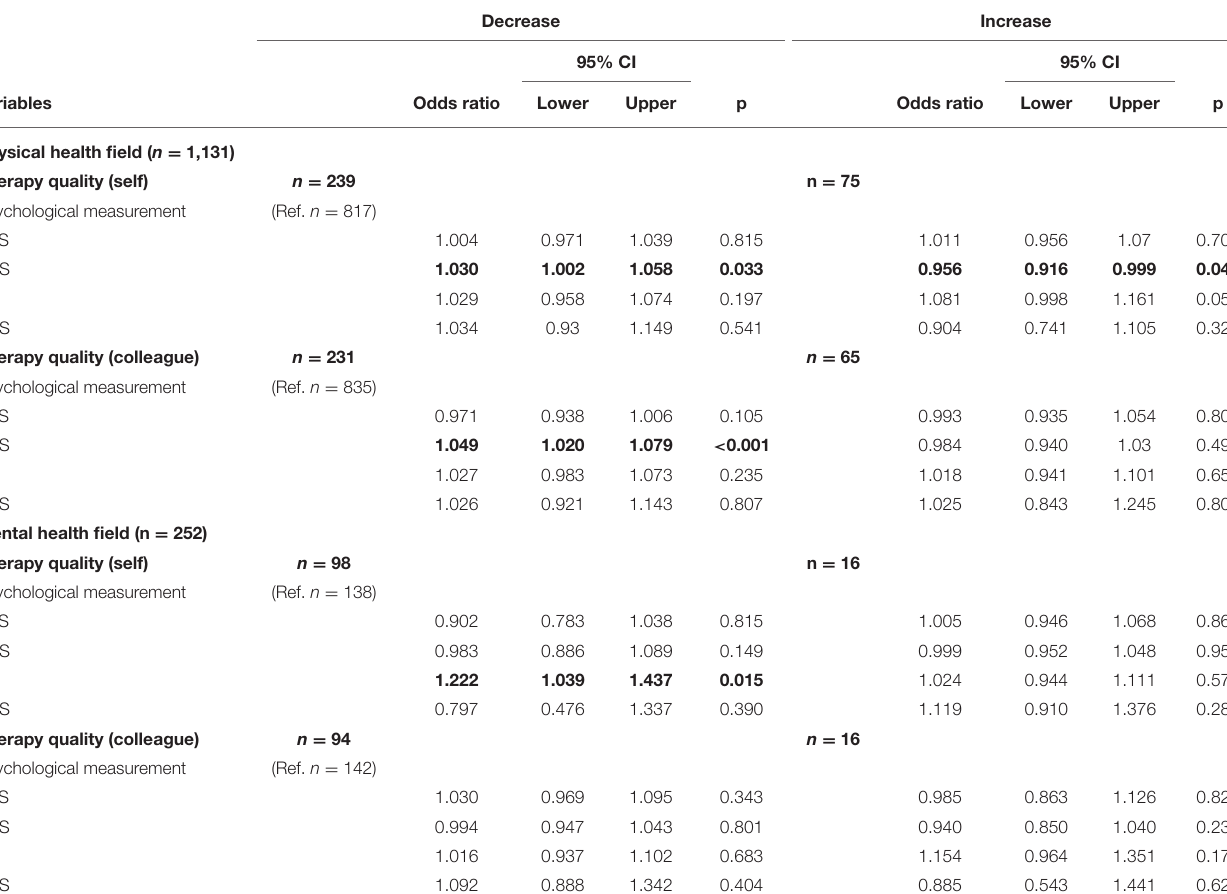
TABLE 3 | Multinominal logistic regression results predicting psychological impacts on quality of treatment among occupational